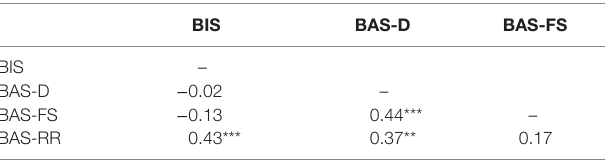
TaBle 1 | Person zero-order correlations for Bis and Bas